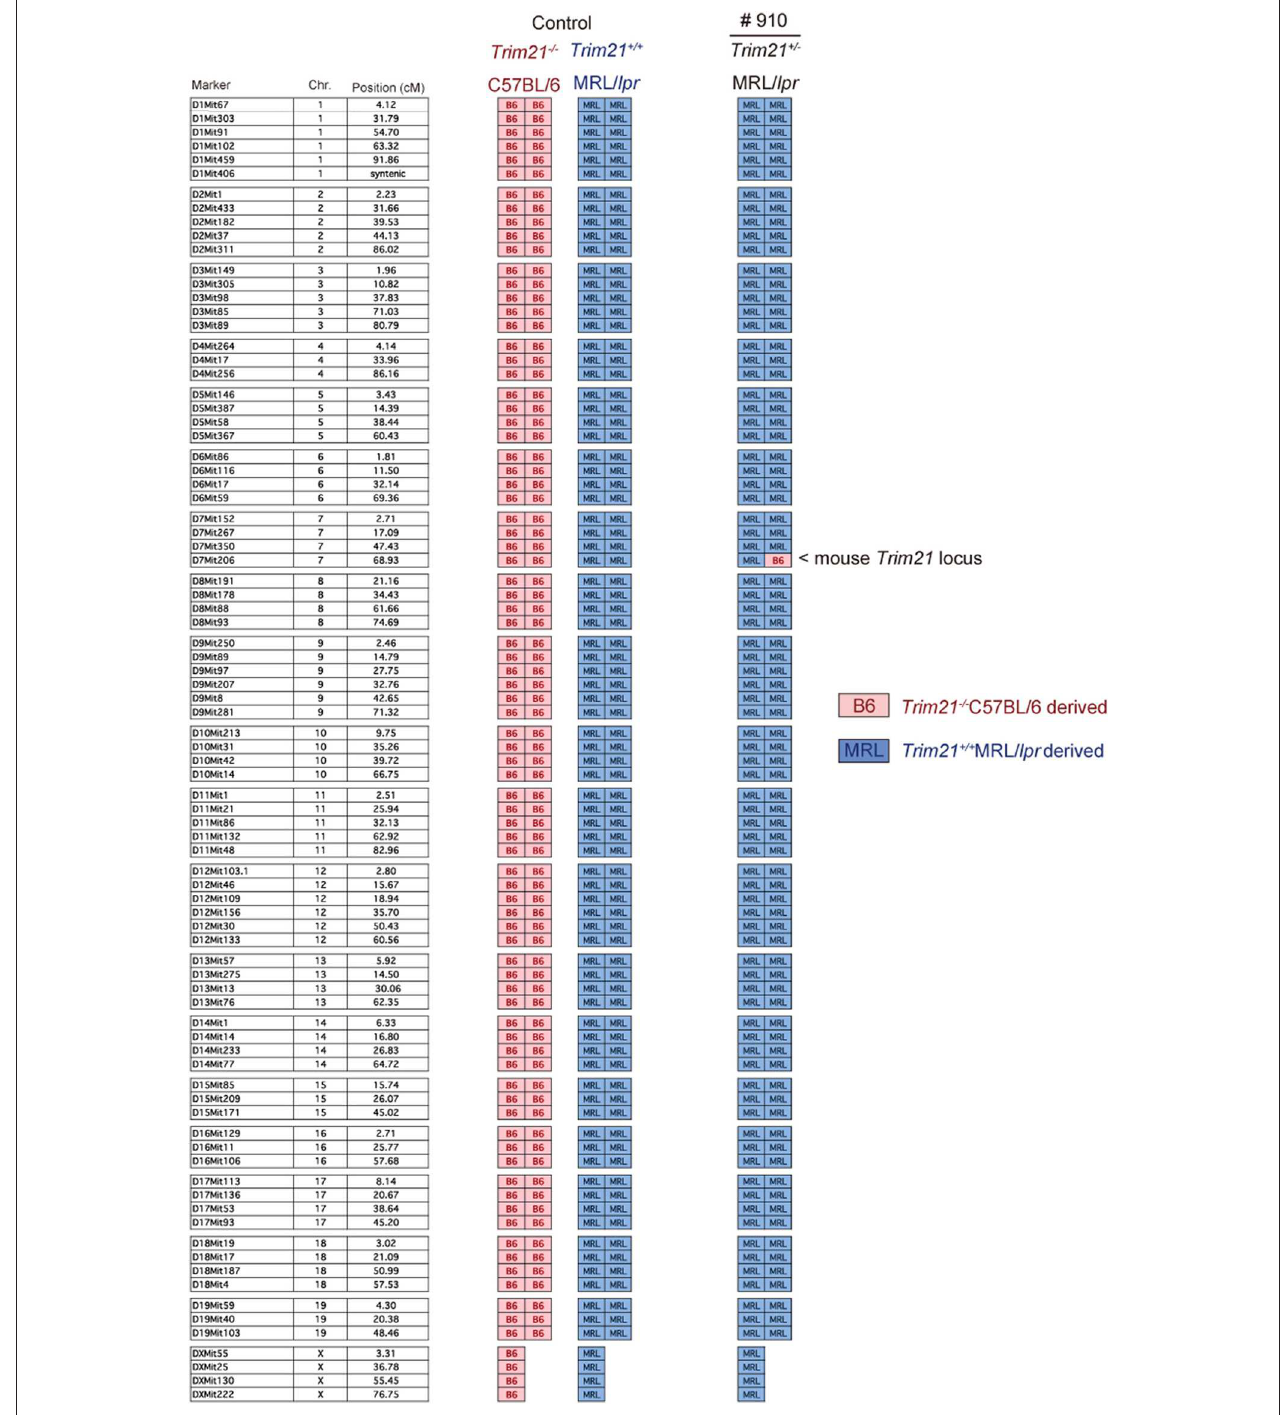
FIGURE 2 | Genome scanning of backcrossed Trim21 + / − MRL/ lpr mice. A comprehensive examination of the genotype of Trim21 + / − MRL/ lpr mouse (Mouse # 910) generated by back-crossing for more than ten generations. Chr., chromosome.